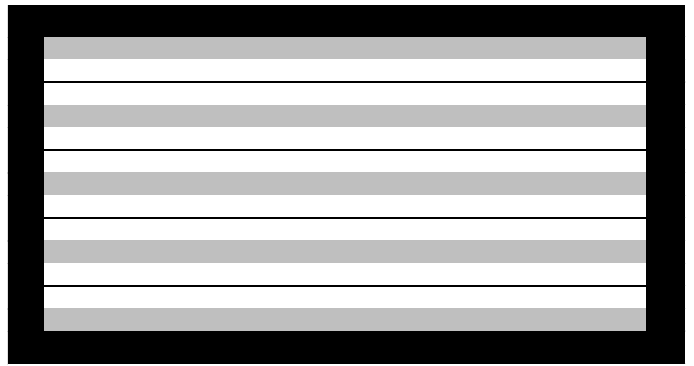
Figure 1. Field design utilized in this study. Black border represents border rows grown from viruliferous thrips-containing onion bulbs saved from previous year. Gray rows represent spreader rows. White rows represent test entries including plant introductions (PIs), first-, and second-generation selections.